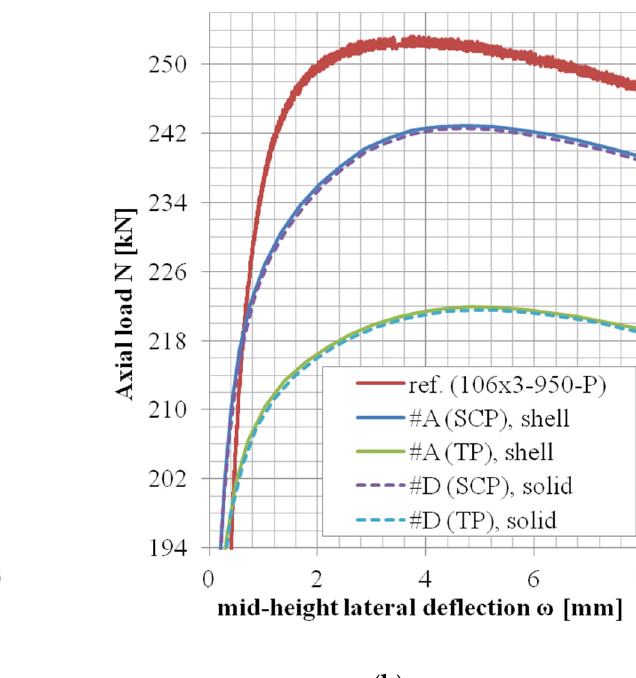
Figure 7. Experimental and FE loads vs. midheight lateral deflection curves of 106 × 3-950-P [38]: ( a ) whole; ( b ) zoomed.